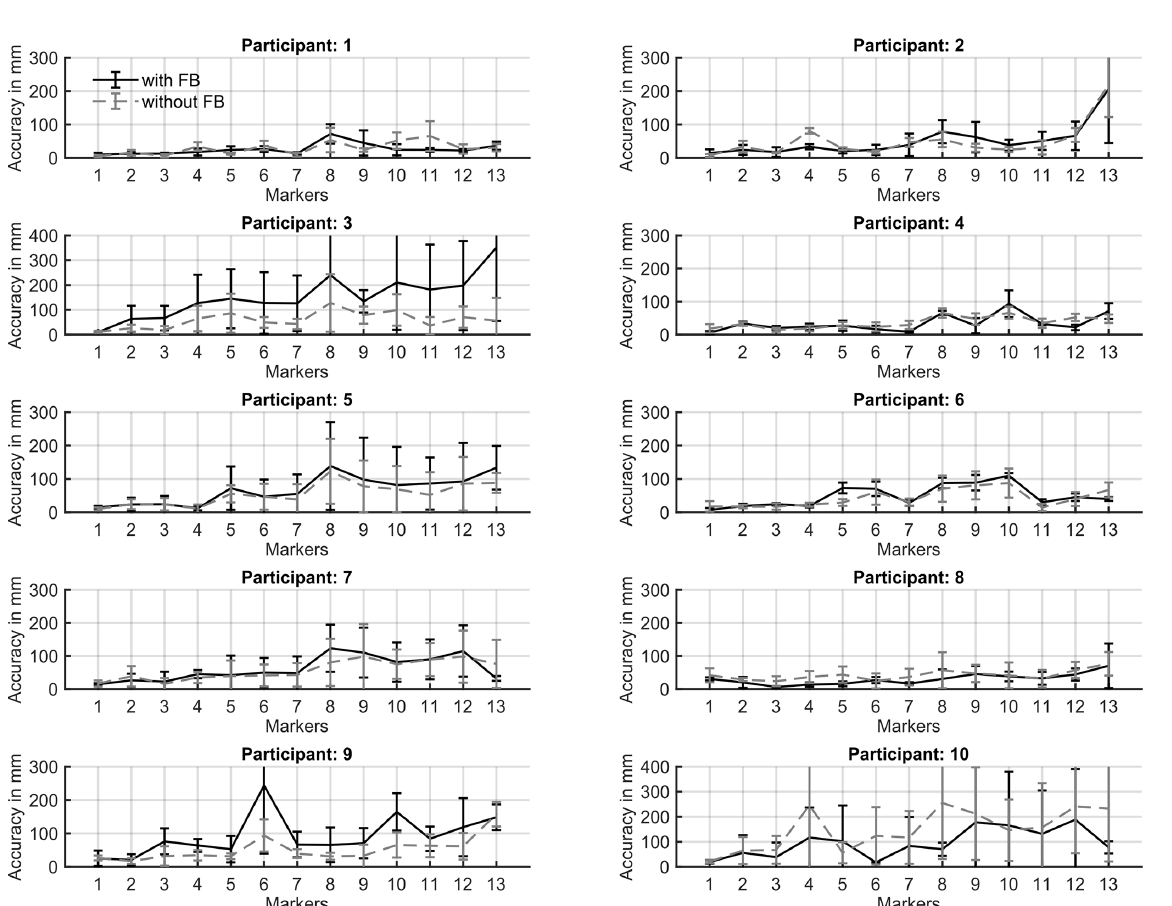
Figure 3. Weighted average for both conditions (activated vibrotactile feedback, black; deactivated vibrotactile feedback, grey – dashed line). The distribution of the markers is shown in Fig.